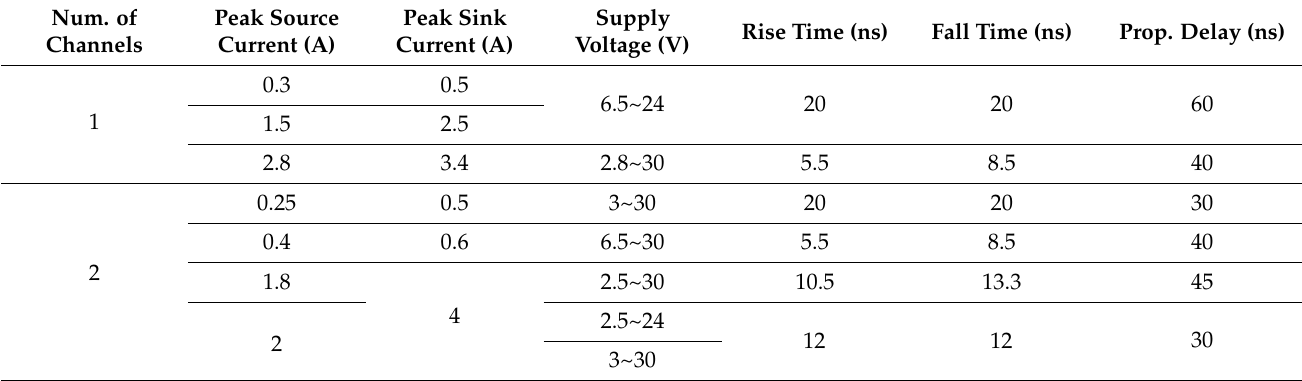
Table 24. Commercial GaN HEMT drivers by Silicon